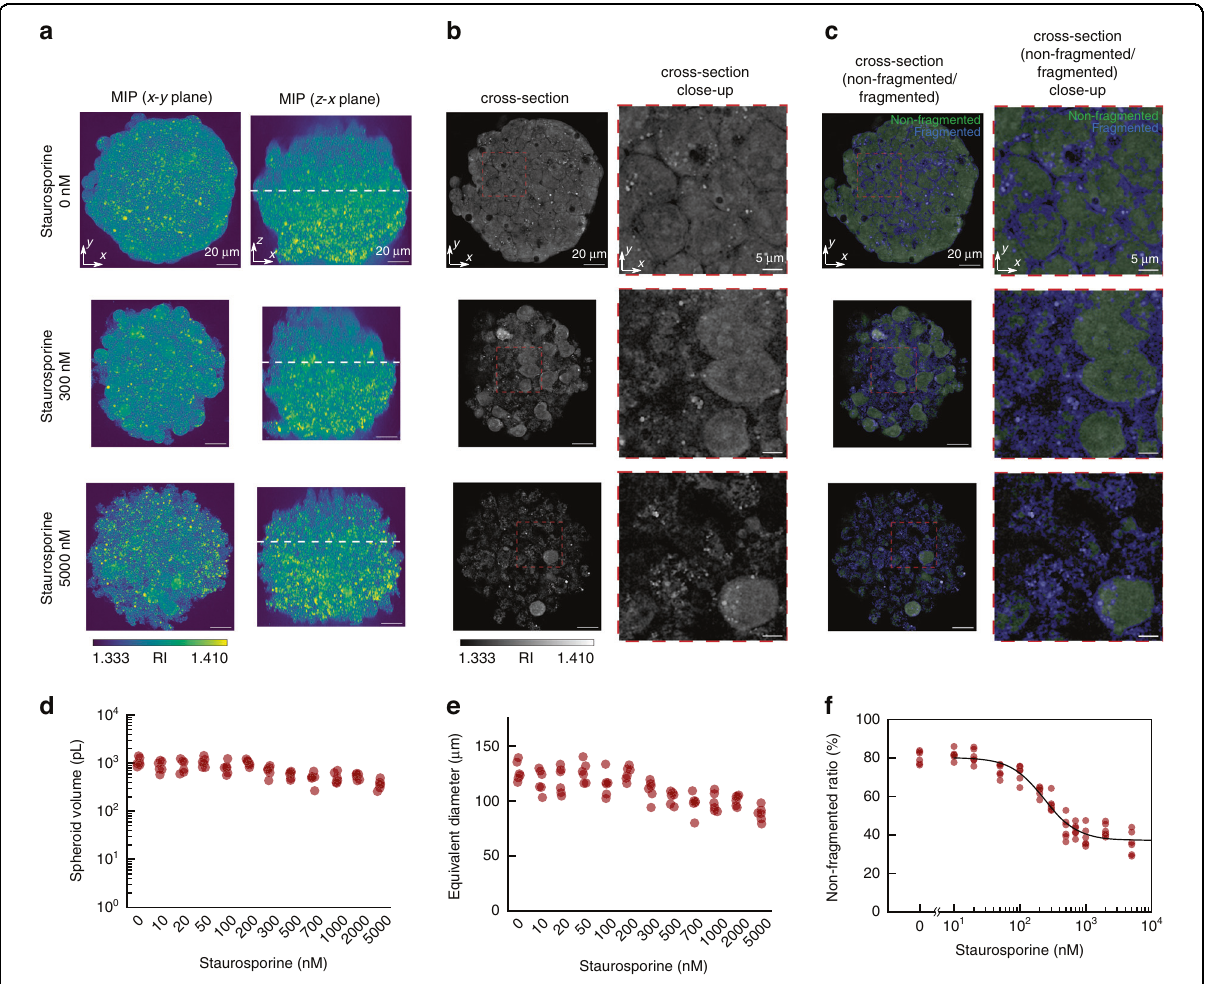
Fig. 6 Semi-quantitative assessment of staurosporine-induced morphological changes in HepG2 spheroids using in-silico clearing RI tomography. a Maximum intensity projection (MIP), b cross-sections, and c cross-sections merged with non-fragmented/fragmented areas of RI maps of HepG2 spheroids at staurosporine concentrations of 0, 300, and 5000 nM, respectively. The cross-section is identi fi ed with white dashed lines in the MIP image. The movies showing all cross-sections are provided in Supplementary Movies 4 – 6. Plots of ( d ) spheroid volume, ( e ) equivalent diameter, and ( f ) non-fragmented ratio as a function of staurosporine concentration. Six spheroids were measured for each staurosporine concentration (a total of 72 spheroids). The black solid line in ( f ) denotes the fi tted based on the Hill model. The relative 50% effective concentration EC 50 = 233 nM and the Hill exponent H =